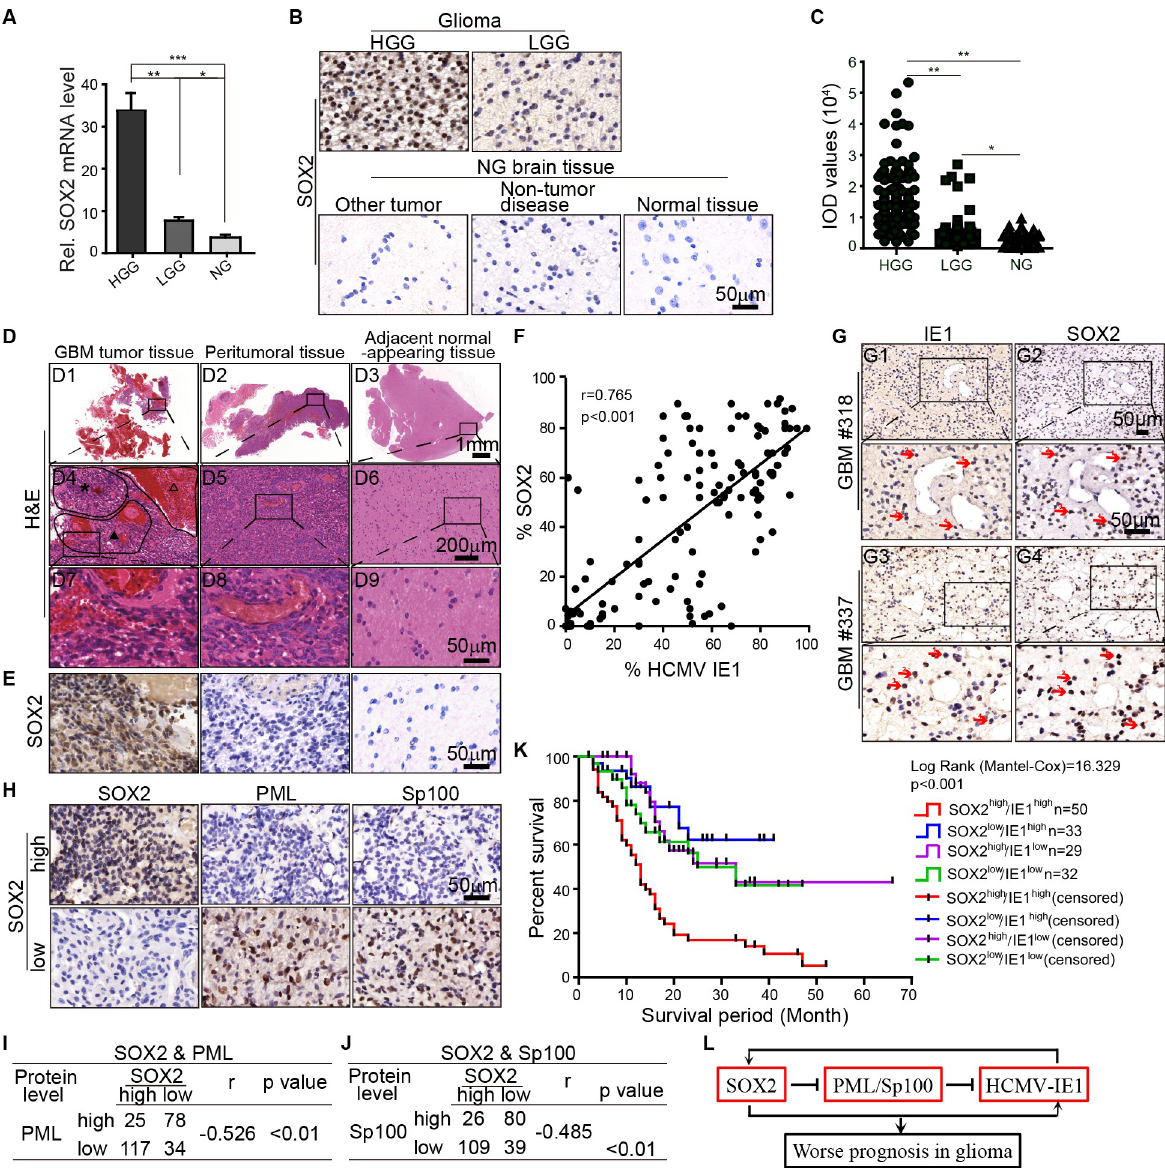
Fig 7. Positive correlation of SOX2 and IE1 expression in gliomas and survival analysis. ( A ) Relative mRNA levels of SOX2 in tumor tissue of HGG (n = 112), LGG (n = 60), and NG (n = 152). ( B ) Representative images of IHC staining of SOX2 in paraffin-embedded brain tissue of HGG, LGG, and NG. ( C ) SOX2 protein levels in brain tissues were quantified from IOD analyses of five random fields per specimen. LGG, n = 178. LGG, n = 76. LGG, n = 108. ( D ) Regions within a representative GBM brain specimen were classified as tumoral (D1), peritumoral (D2), and areas of the adjacent normal-appearing brain (D3) based on histopathology. In D1, the areas of abnormal cell proliferation (asterisk), necrosis (hollow triangle), and vascular proliferation or angiogenesis (solid triangle) are enlarged (D4). Further magnification in D4 shows vascular proliferation or angiogenesis (D7). For comparison, similar magnifications are shown of regions identified as peritumoral (D5, D8) or adjacent normal-appearing brain (D6, D9). ( E ) SOX2 staining in representative regions of D7-9. ( F ) Correlation between SOX2 and IE1 expression in 178 HGG subjects. SOX2 and IE1 immunostaining was quantified as previously mentioned, and the correlation was assessed by Pearson correlation analyses. ( G ) Co- expression of SOX2 and IE1 in glioma tissues. SOX2 and IE1 were stained in adjacent sections in GBM tissues by IHC; representative images and the corresponding magnification from two cases (#318 and #337) are shown. ( H ) Expression of SOX2, PML, and Sp100 in gliomas. Tumor tissues from 254 glioma patients were stained by using SOX2, PML, and Sp100 antibodies, respectively. Correlation analyses show SOX2 significantly inversely correlates with PML ( I ) and Sp100 ( J ). ( K ) Survival analysis. Patients (n = 144) were stratified into four groups based on SOX2 and IE1 expression levels in tumors (based on IHC scoring) and analyzed by Kaplan-Meier curves. Statistical significance was determined using the Log- rank (Mantel-Cox) test. ( L ) Model of the regulation of SOX2-PML axis on HCMV infection in gliomas. Data in ( A and C ) represent as means ± SD (One-way ANOVA along with the Tukey post-hoc multiple comparisons; * , p < 0.05; ** , p < 0.01; *** , p < 0.001).